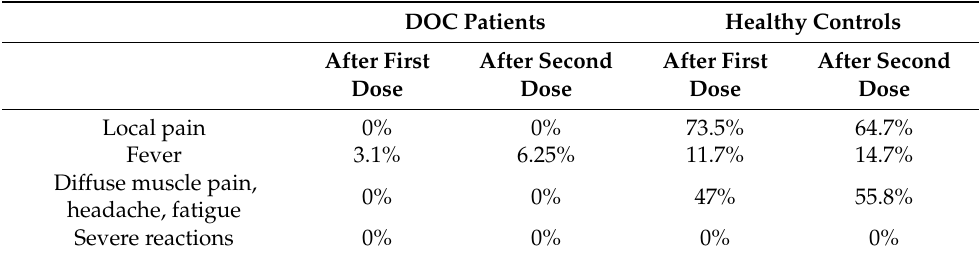
Table 2. Adverse events after the first or second dose of